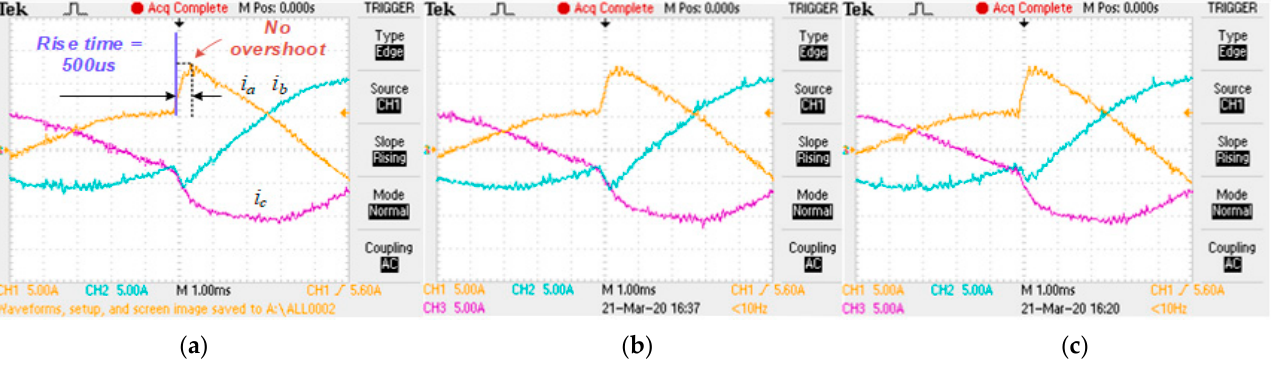
Figure 8. Transient analysis of current control, without feedforward compensation. ( a ) abc–PR, ( b ) αβ –PR, and ( c ) dq ‐ PI.